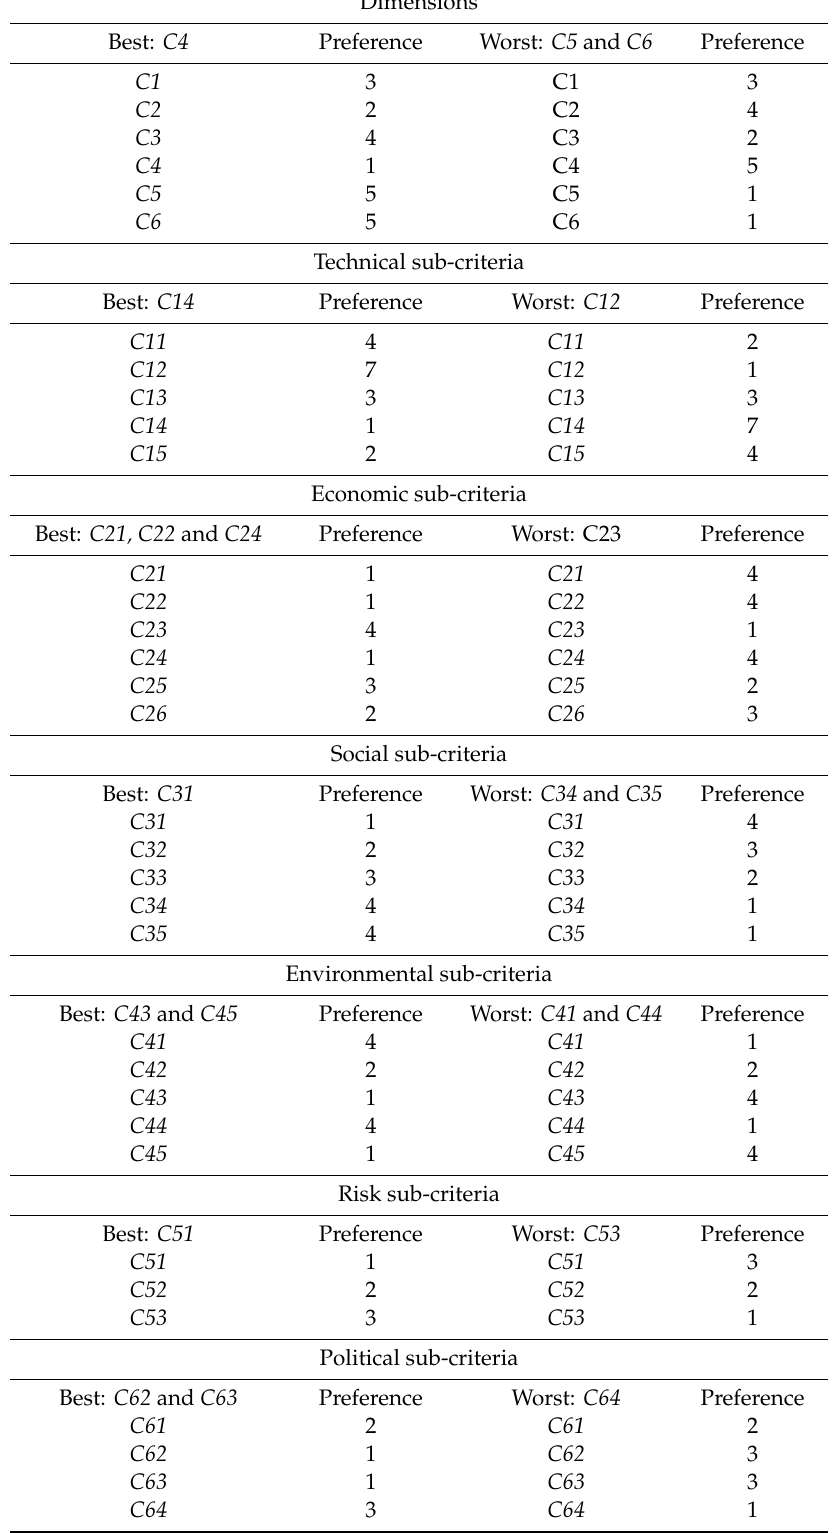
Table 3. The best-to-others (M-BO) and modified others-to-worst (M-OW) vectors of the dimensions /